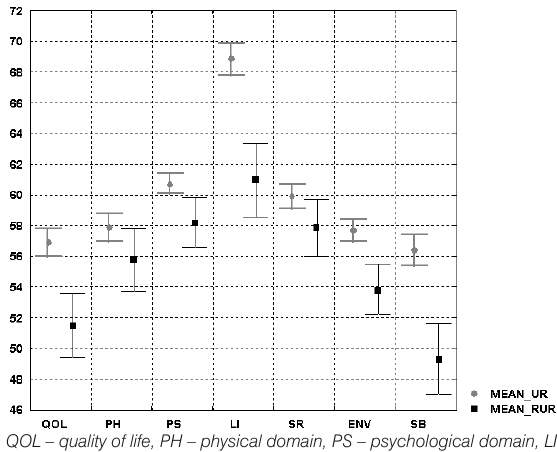
Figure 1. Comparison between the WHO-QOL-100 mean scores in urban and rural random samples.